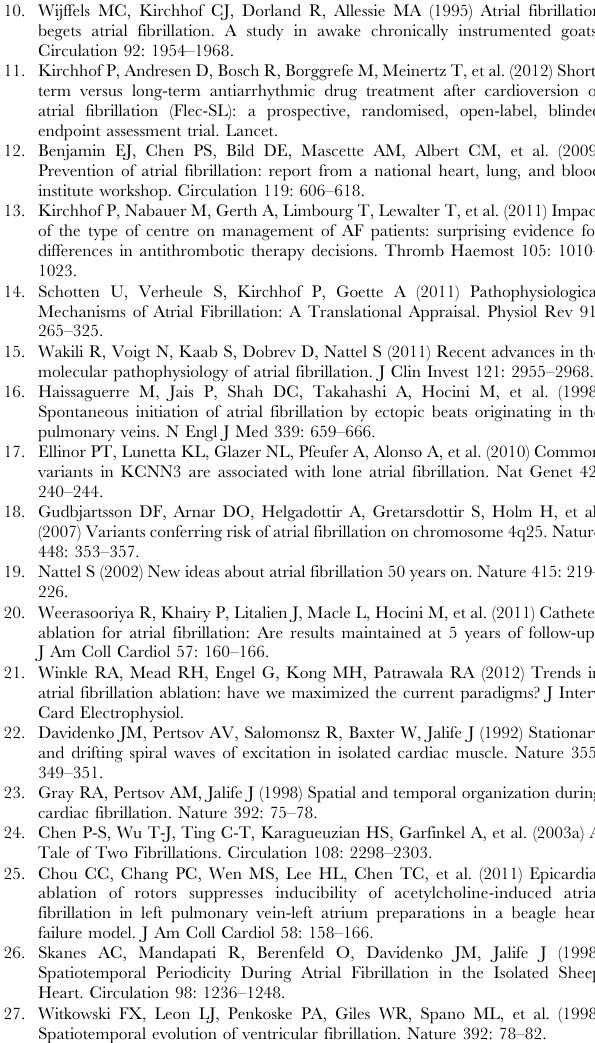
clockwise left atrial rotor on the posterior left atrium near (but not within) the left pulmonary vein antra, where localized ablation (red dots in right panel) terminated AF to sinus rhythm within 3 minutes. Both patients are free of AF on implanted monitors. (TIF) Figure S5 Kaplan-Meier curves for freedom from AF, detected using rigorous monitoring including implanted continu- ous ECG recordings.